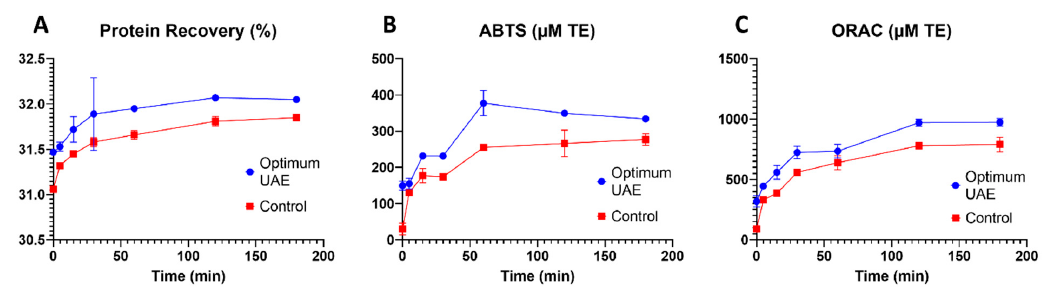
Figure 6. Optimal condition of UAE vs. conventional extraction (Control) for sea bass head: ( A ) protein recovery (%), ( B ) ABTS values (µM TE), and ( C ) ORAC values (µM TE).